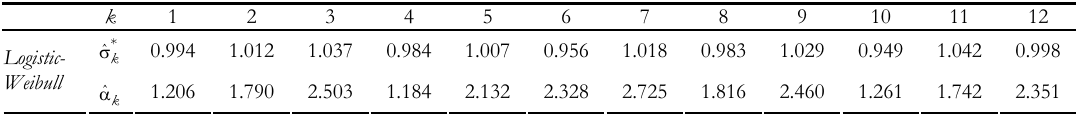
Parameter estimates for the Logistic-Weibull